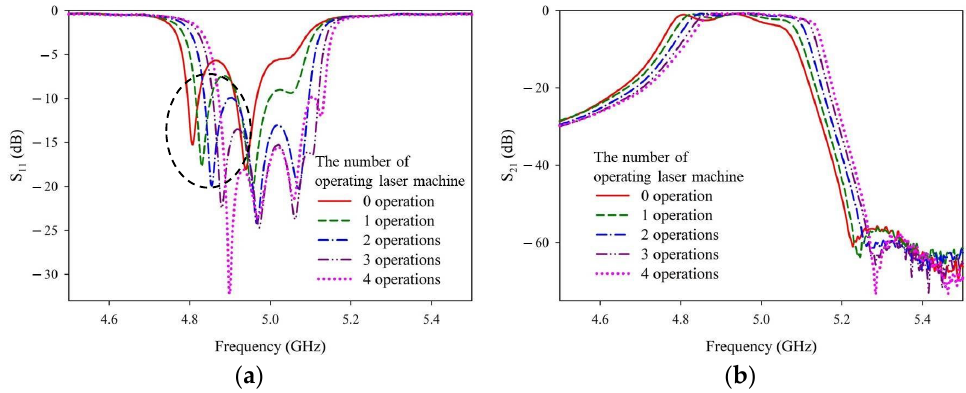
Figure 14. Measured ( a ) S 11 and ( b ) S 21 values after different numbers of operations with the 4w_30k_100_re10 recipe. The solid red curves represent ceramic filter samples without laser